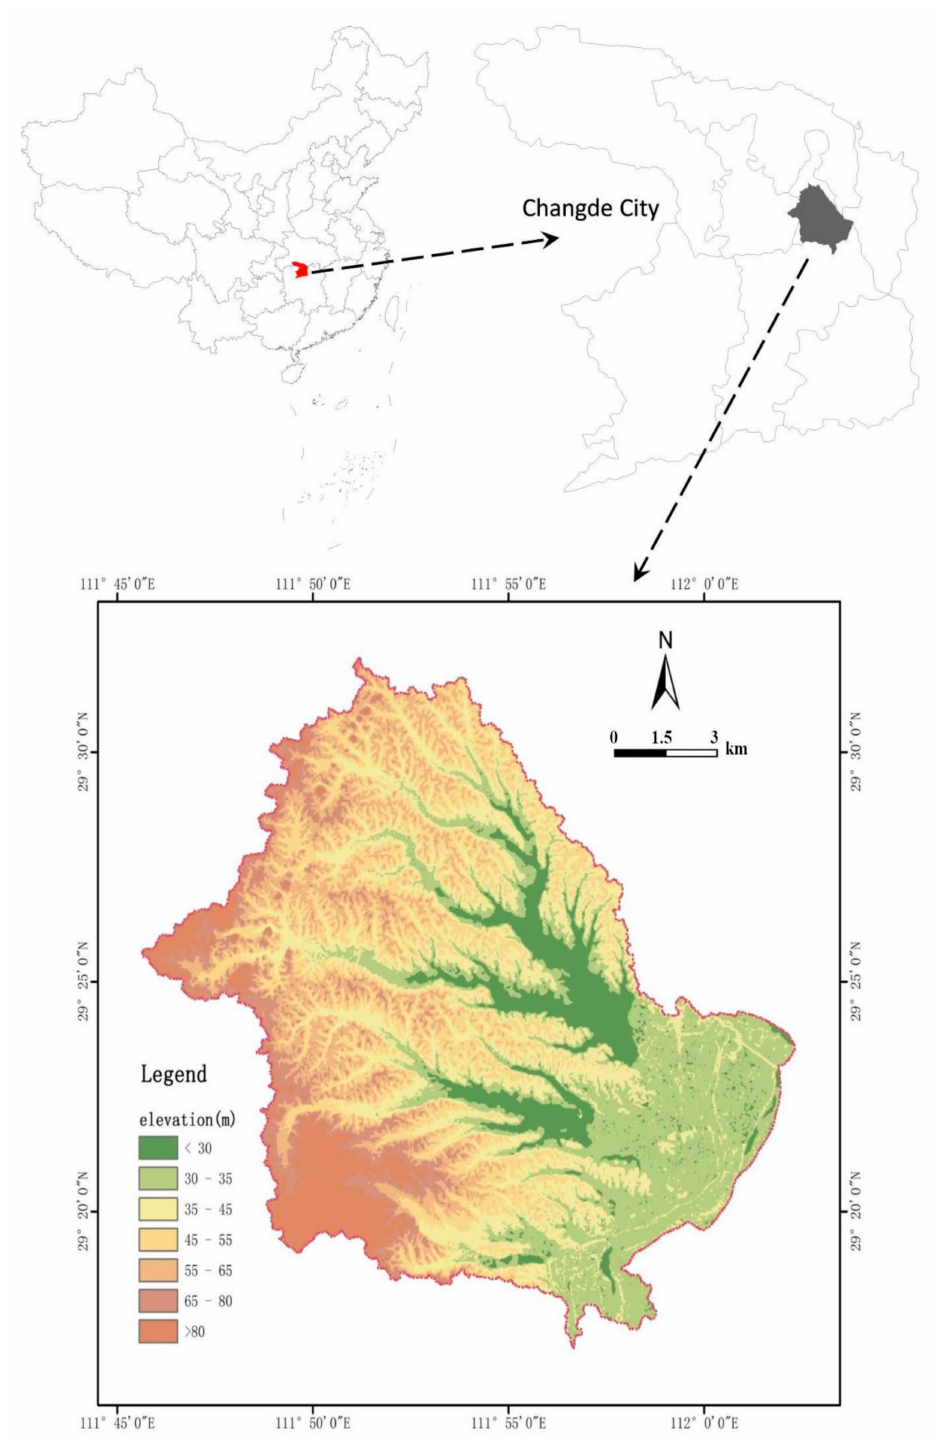
Figure 1. Research area